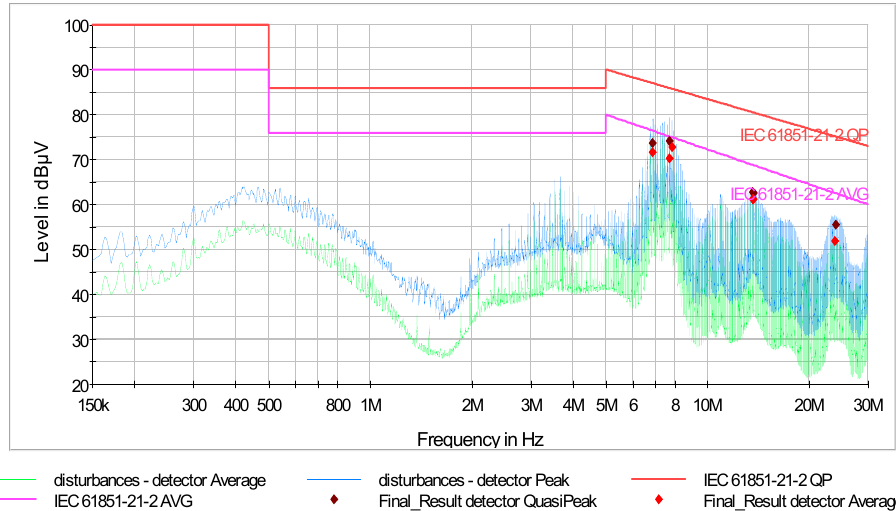
Figure 12. Conductive disturbance of the charging station, DC module operation (80% power), IEC 61851-21-2 limits for average and quasipeak detectors; blue line—disturbance level measured by the peak detector, green line—disturbance level measured by the averaging detector.